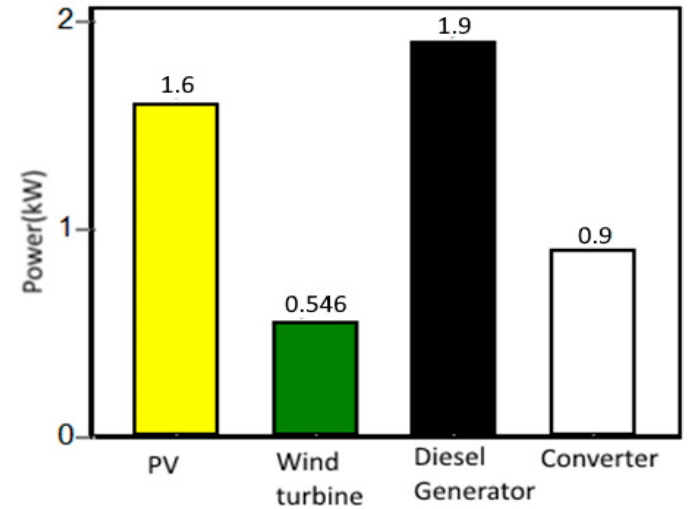
Figure 10. Power of system components used in simulation.